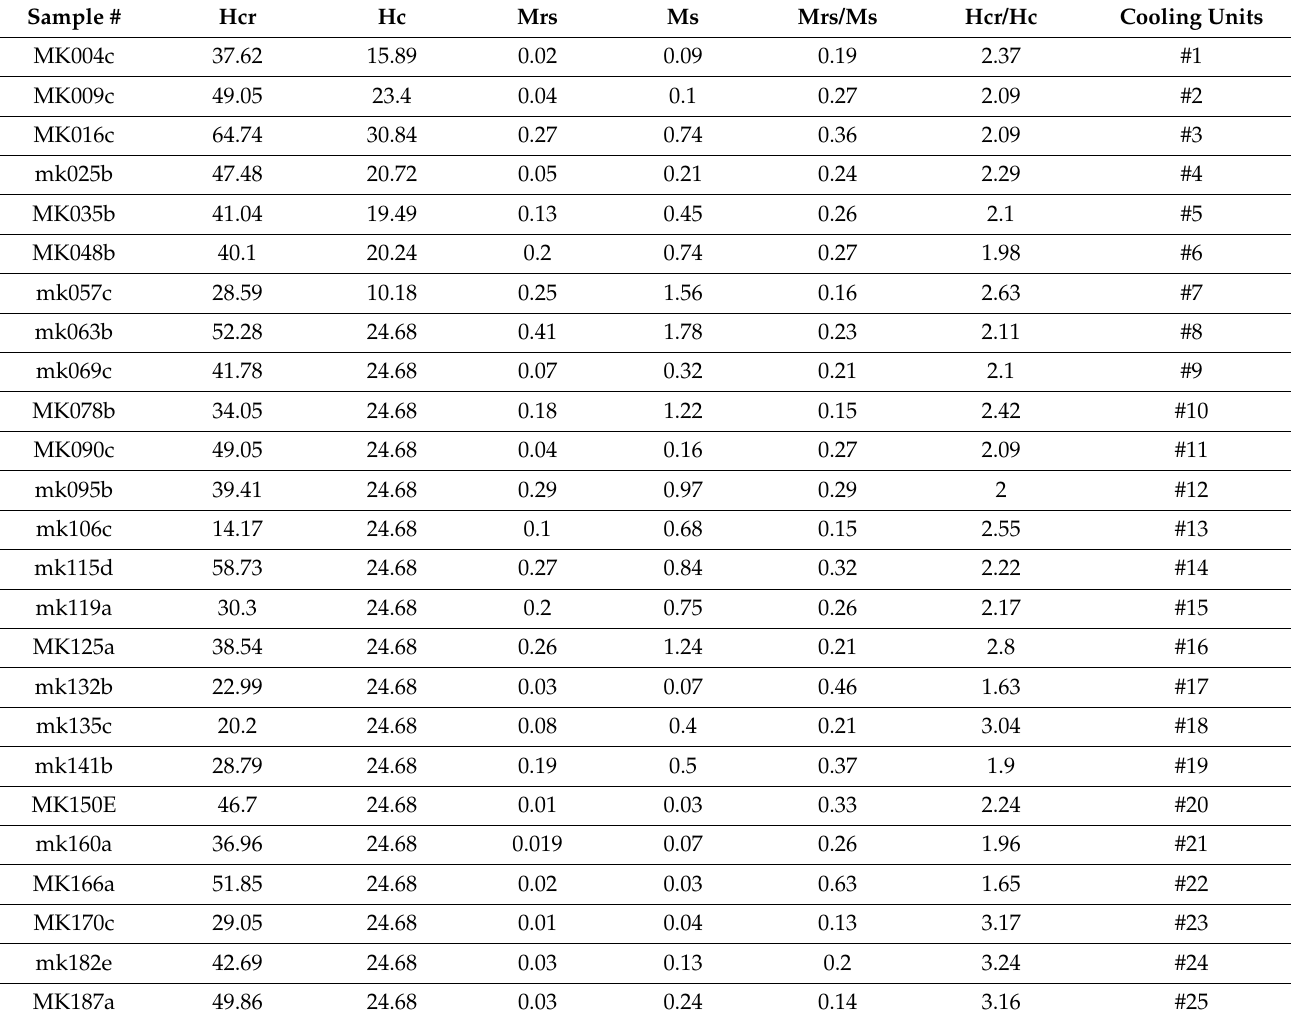
Table 2. Hysteresis results and parameters. Hcr—remanence coercivity; Hc—coercivity; Mrs— remanence saturation; Ms—magnetization